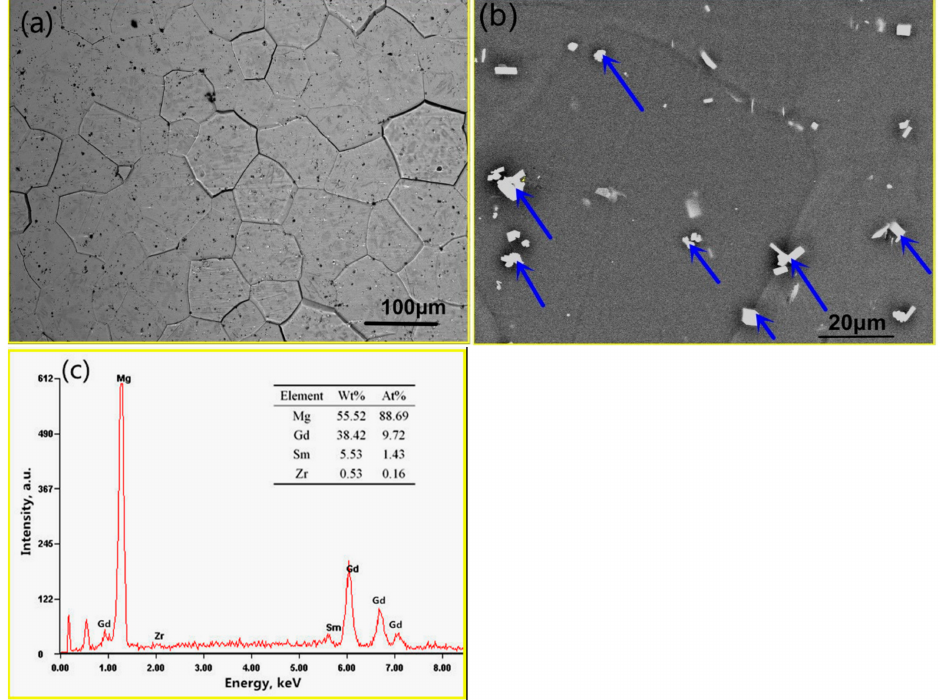
Figure 2. The optical micrograph of homogenized Mg–8.08Gd–2.41Sm–0.30Zr alloy ( a ), BSE image ( b ), and EDS ( c